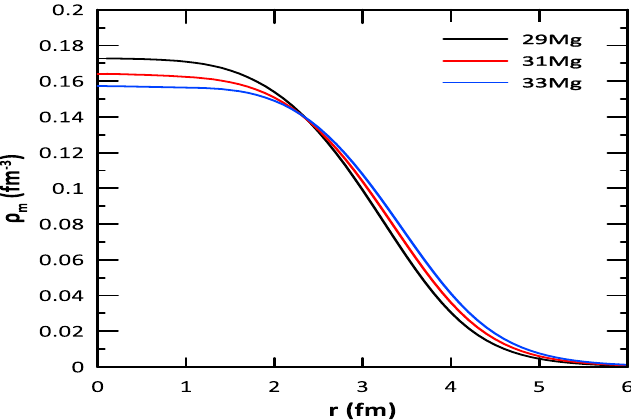
Fig. 7(a): The relation between matter density (fm -3 ) and position r(fm) for 29,31,33 Mg nuclei.